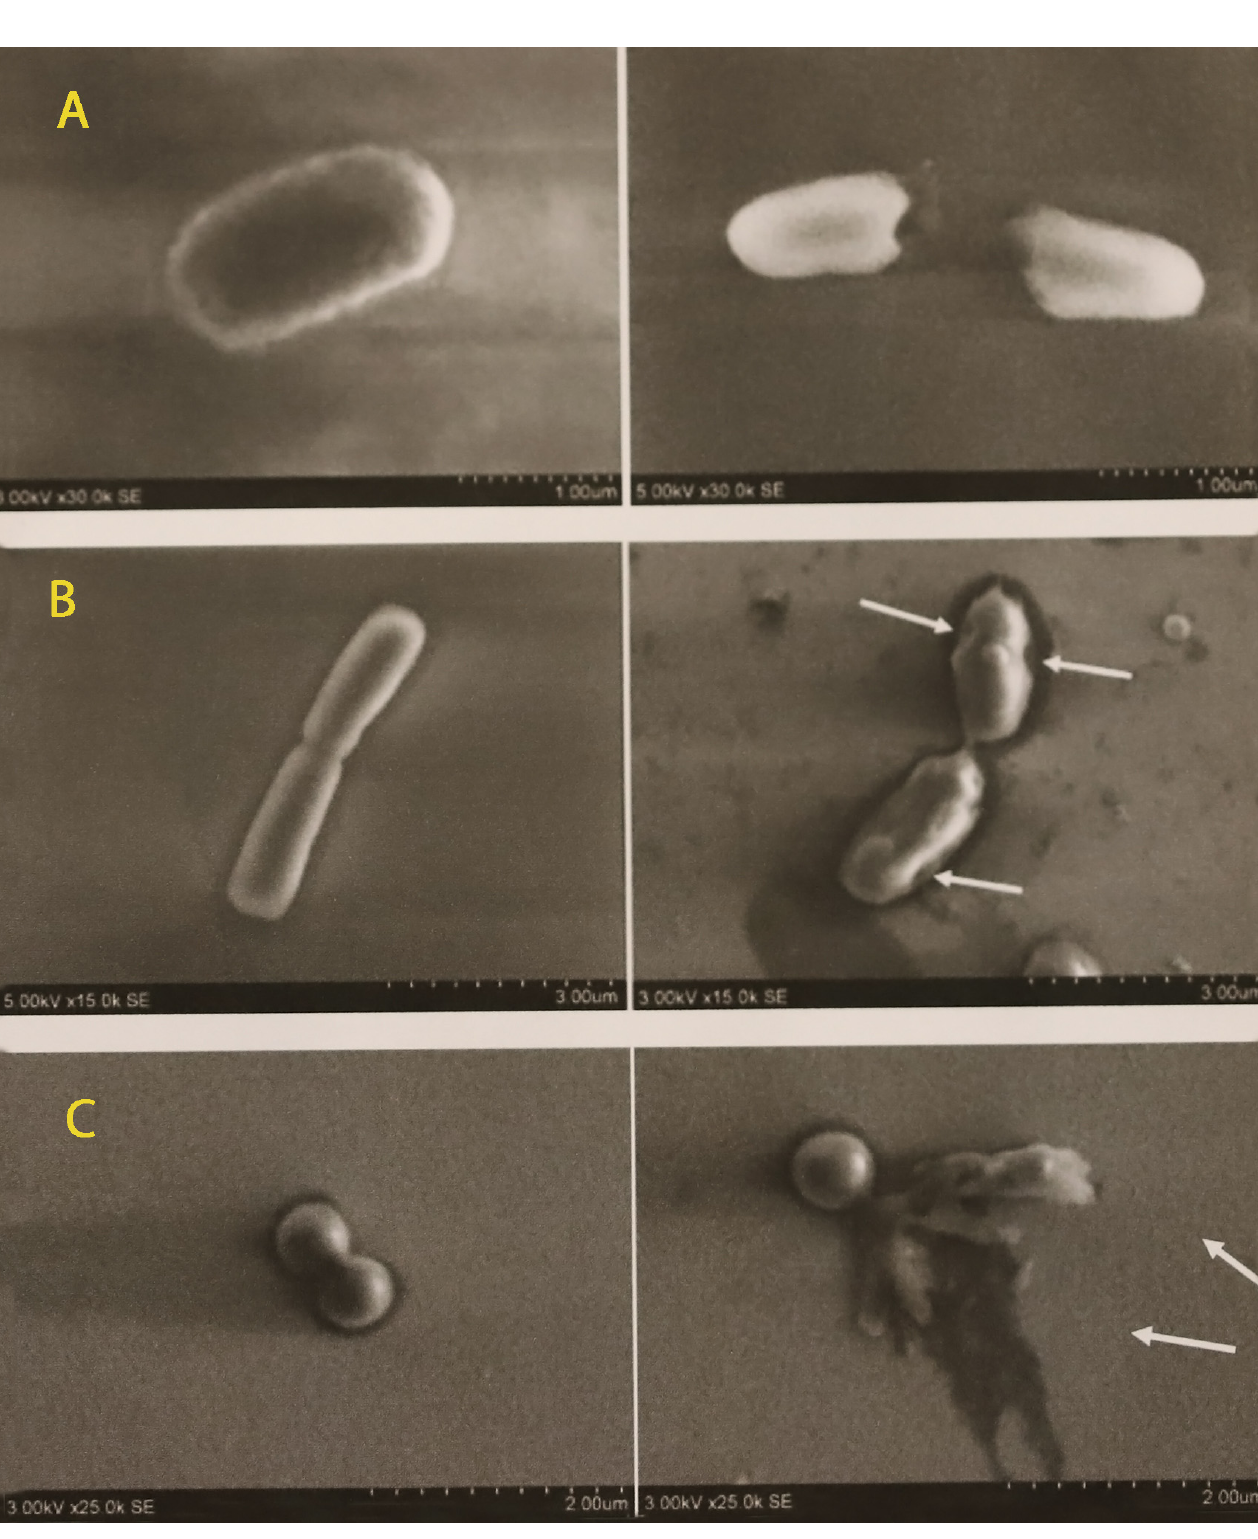
Figure 9. SEM micrographs with non-treated (left) and copper-treated (right) bacterial images: A— Escherichia coli ATCC 25922; B— Bacillus cereus ATCC 11778; C— Staphylococcus aureus ATCC 25923. Damaged cells are marked by arrows.